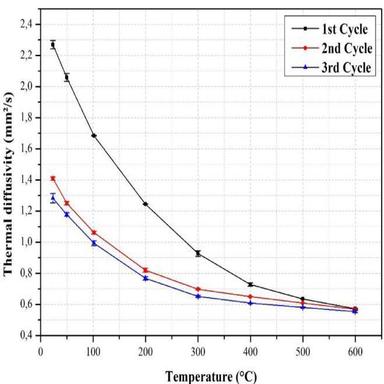
2. Thermal diffusivity measurement of Limestone rock during three consecutive thermal cycles.